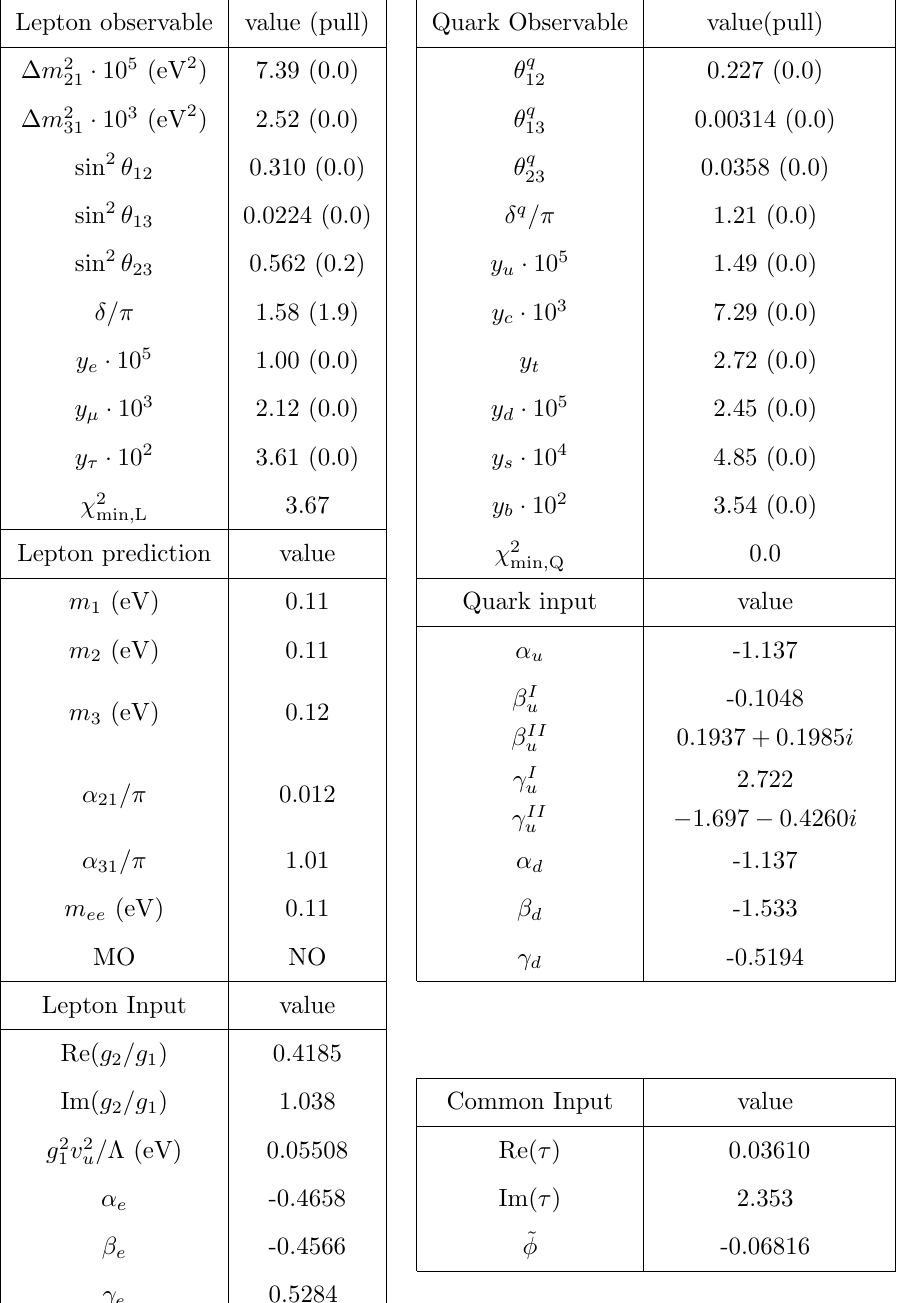
Table 6 . Results of the (cid:12)t to lepton and quark data for model combining M (cid:23) ; Y e ; Y III In the left panel are the lepton observables and pulls (in fractions of 1 (cid:27) ), the (cid:31) 2 from the lepton sector, as well as predictions for neutrino masses, phases, neutrinoless double beta decay and mass ordering. The inputs for the lepton sector are displayed at the bottom. In the right panel we have the quark observables and pulls, the (cid:31) 2 At the bottom right we list the (cid:28) and (cid:30) inputs which are common to both sectors. We note that ~ (cid:30) = 1 = 15 = 0 : 06667 for example may be (cid:12)xed exactly to (cid:12)nd an equivalently good benchmark